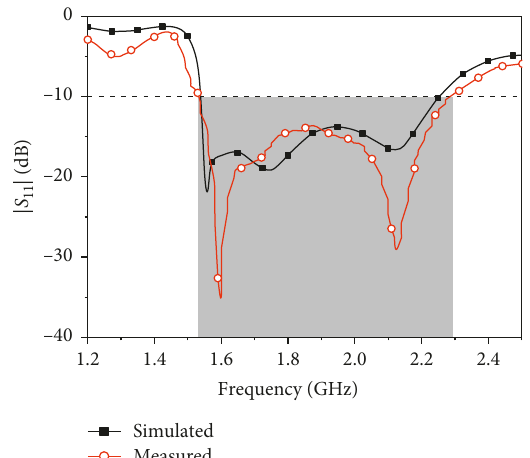
Figure 11: Simulated and measured | S